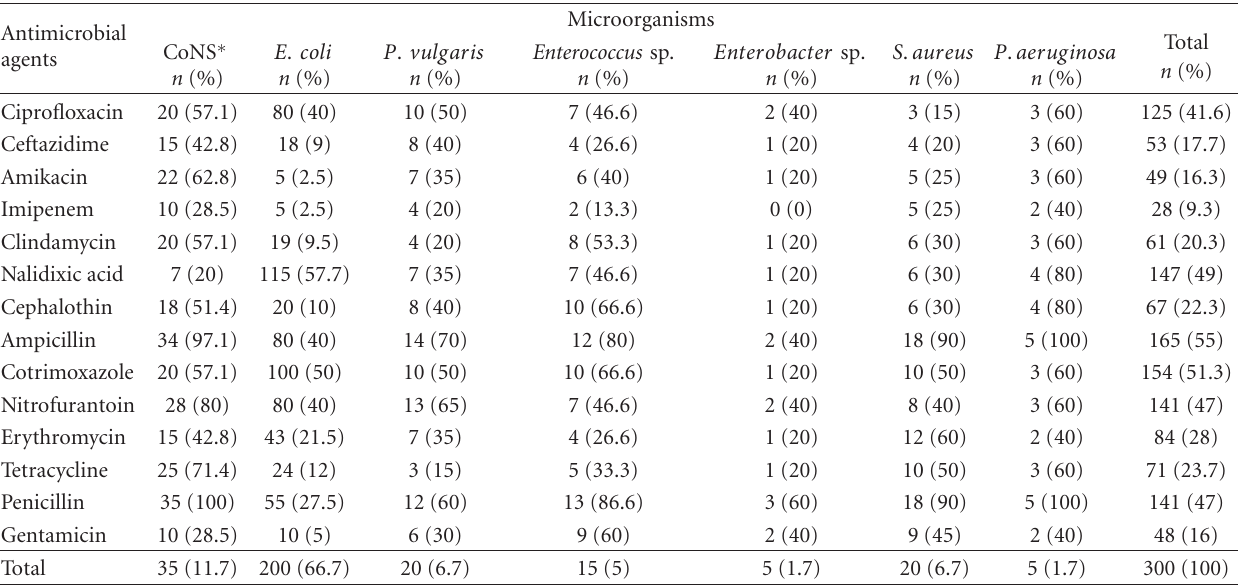
Table 2: Antimicrobial resistance profiles of hospital-acquired bacterial isolates from clinical urine specimens.